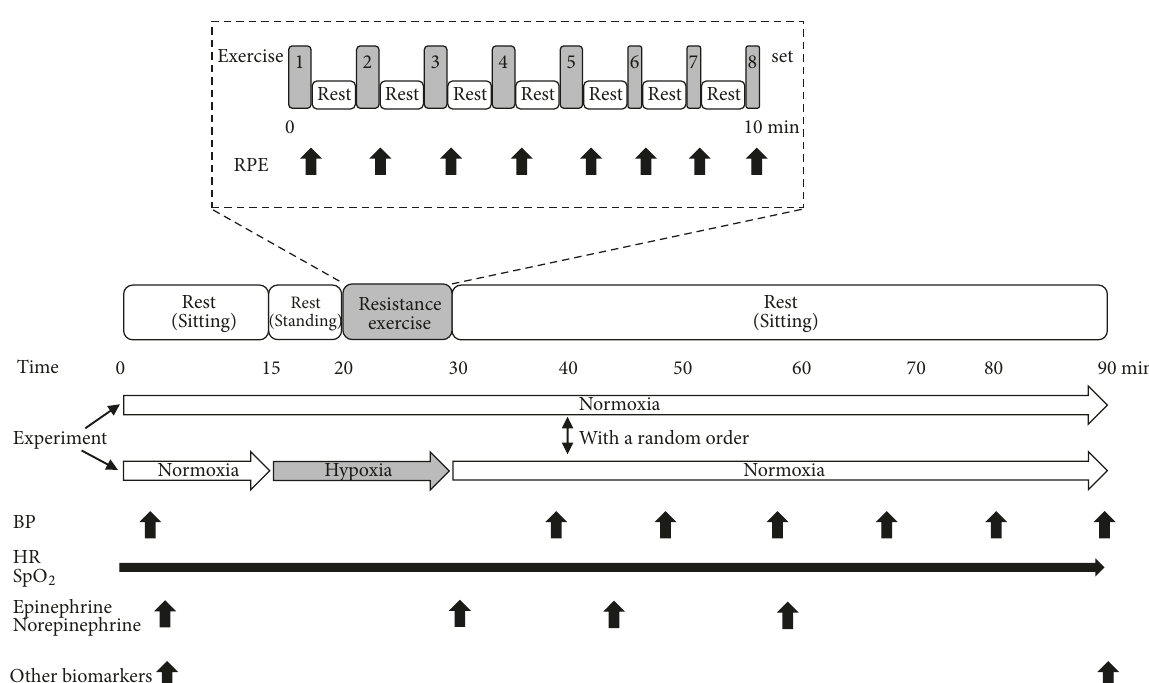
Figure 1: Experimental protocol of the present study. BP: blood pressure, HR: heart rate, and SpO 2 : arterial oxygen saturation. RPE: rate of perceived exertion. Black arrows indicate measuring points and